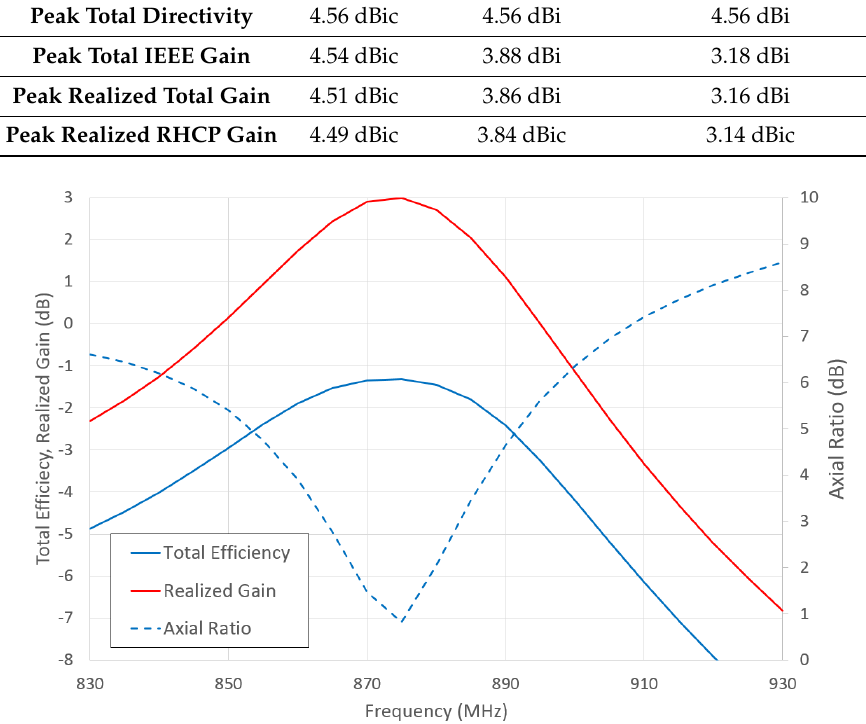
Figure 6. Realized gain, total efficiency, and axial ratio versus frequency.